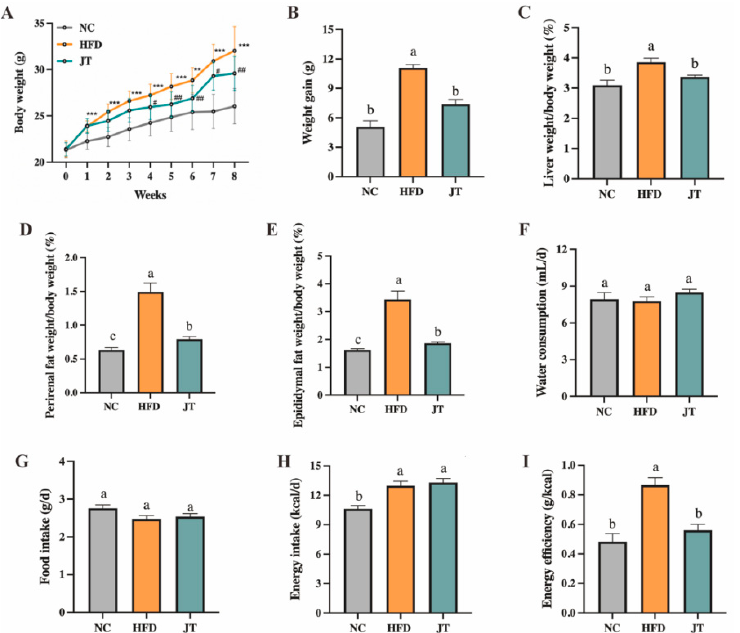
Figure 1. CB-JT suppressed HFD-induced abnormal body weight gain, organ weight and food intake. ( A ) Body weight during the 8-week intervention ( n = 8). ( B ) Body weight gain. ( C ) Liver weight/body weight. ( D ) Perirenal fat weight/body weight. ( E ) Epididymal fat weight/body weight. ( F ) Water consumption. ( G ) Food intake. ( H ) Energy intake. ( I ) Energy efficiency. NC: normal-chow group, HFD: high-fat diet group, JT: jasmine tea group. Data are expressed as the mean ± SEM. The mean value with different letters indicates significant differences ( p < 0.05). HFD vs. NC: ** p < 0.01, *** p < 0.001; JT vs. HFD: # p < 0.05, ## p < 0.01, ns for no significance.